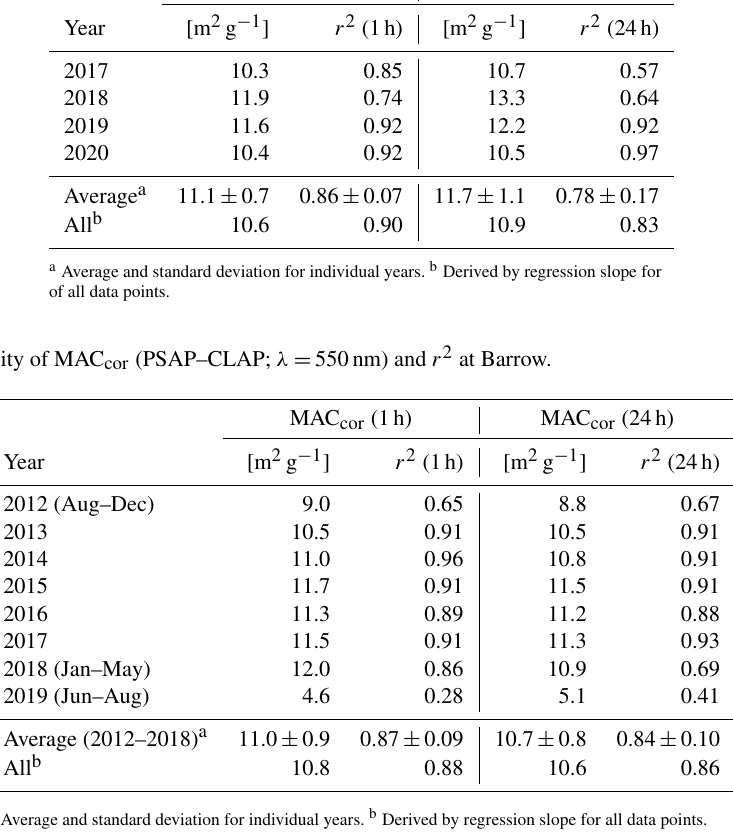
Table 8. Year-to-year variability of MAC cor (MAAP; λ = 637nm) and r 2 at Ny-Ålesund.